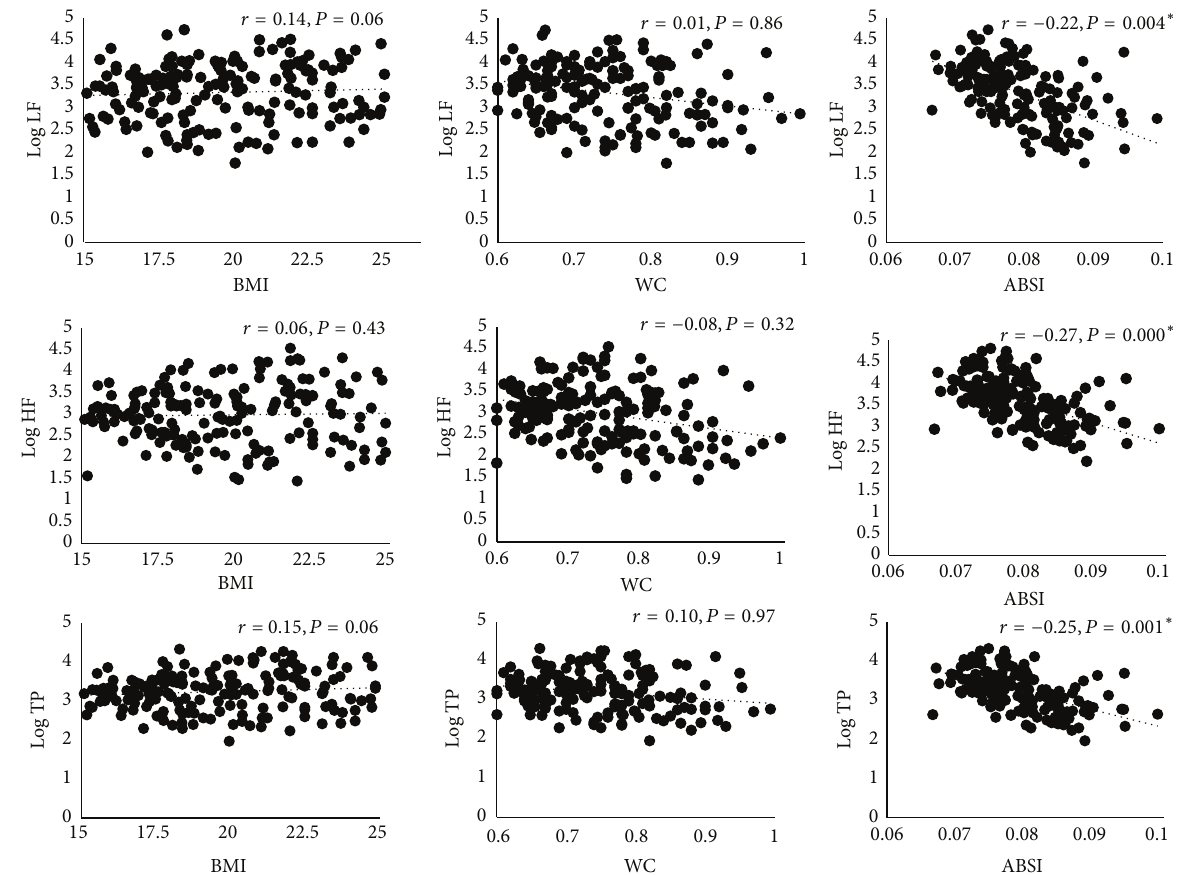
Figure2:ScatterplotsrepresentingthepartialcorrelationbetweenBMI,WC,ABSI,andHRVafteradjustingforage.Variablesarerepresented after adjusting for age. ∗ 𝑃 < 0.05 is considered statistically significant. Correlations without adjusting for age are represented in the results.